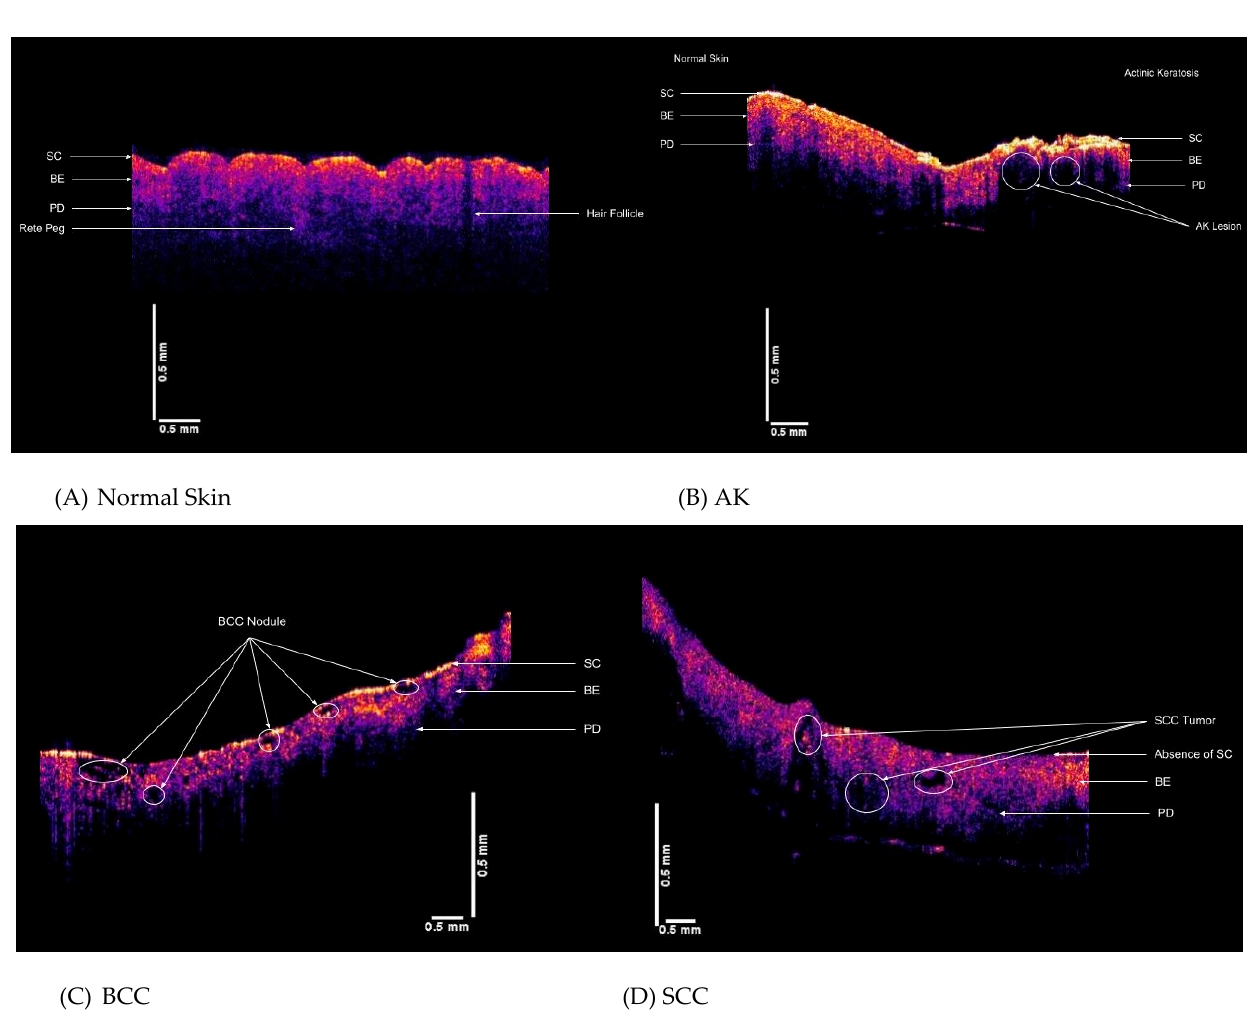
Figure 4. Comparison of color-coded OCT images for ( A ) normal skin, ( B ) AK, ( C ) BCC and ( D ) SCC lesions. In normal skin ( A ) the stratum corneum (SC), basal epithelium (BE) and papillary dermis are (PD) are characteristic of the skin along with the undulating rete pegs. In the AK lesion ( B ) normal skin is seen on the left while the pre-cancerous lesion is seen on the right. In the region of the AK lesion on the right, the basal epithelium and papillary dermis are truncated and replaced with a tumor containing fibrous tissue that reflects light. However, the resonant frequency of the fibrous collagen deposited and the peak height are different than what is seen in cancerous lesions (see Figure 3). The stratum corneum (SC) is thickened and is hypercellular. In BCC ( C ) and SCC ( D ) the stratum corneum (SC) is reduced in size or fragmented and the lesion is seen as either circular or elongated nodules. The rete pegs are missing and black lesions are embedded in the epidermis. There are some basal epithelium (BE) and the papillary dermis (PD) that are reduced in size in the lesion on the right.